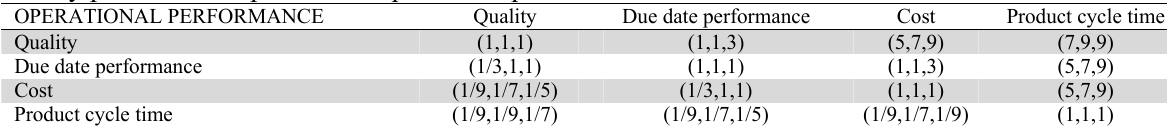
Fuzzy pair-wise comparison of Operational performance Enablers OPERATIONAL PERFORMANCE